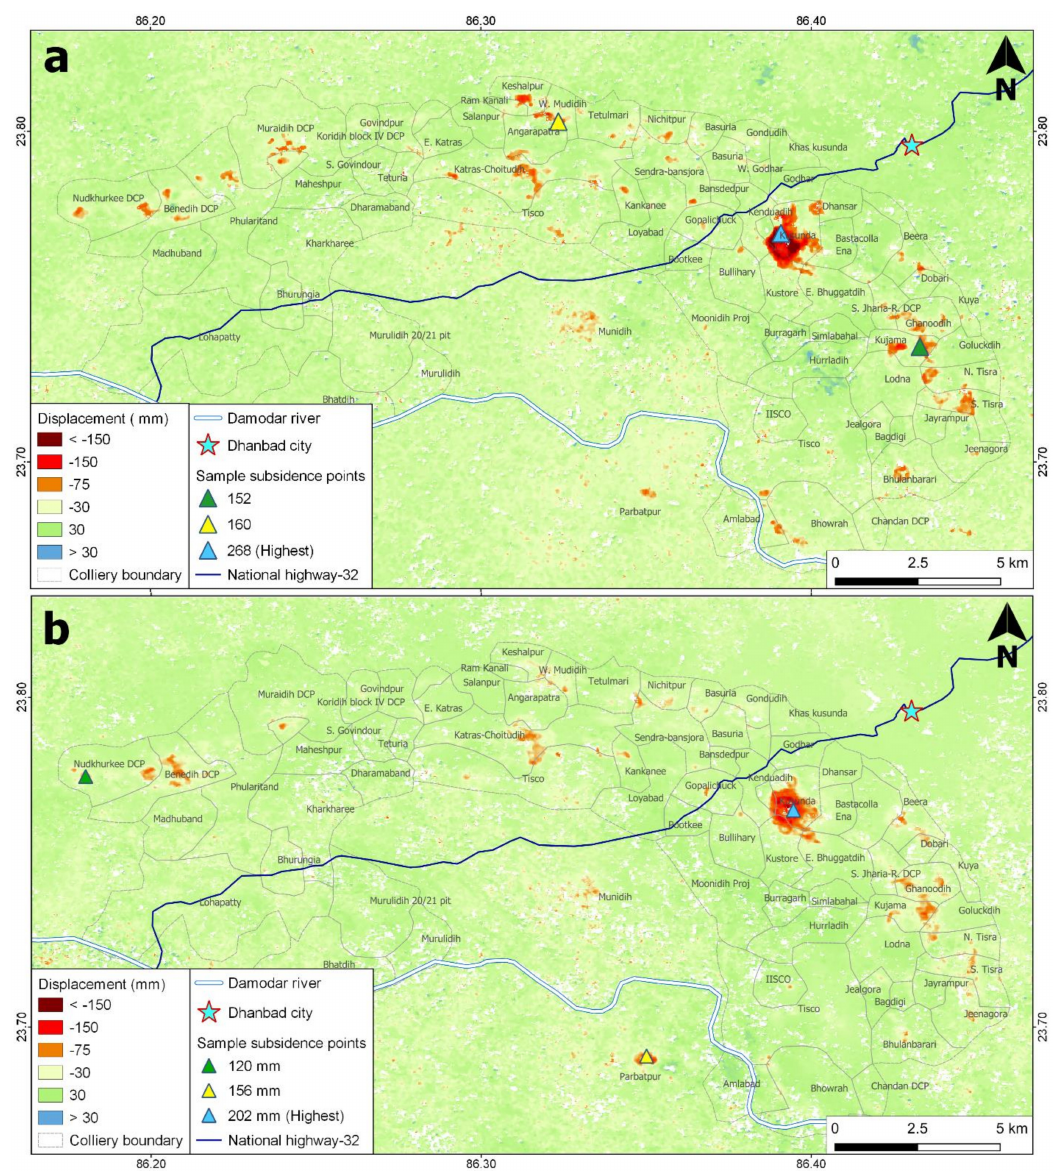
Figure 3. Cumulative line-of-sight (LOS) surface deformation map of JCF from 2017 to 2020 computed using ( a ) Ascending and ( b ) Descending paths of Sentinel-1 data. Colliery boundary overlaid on top of the map is adapted with permission from ref. [69], Copyright 2021 Taylor &